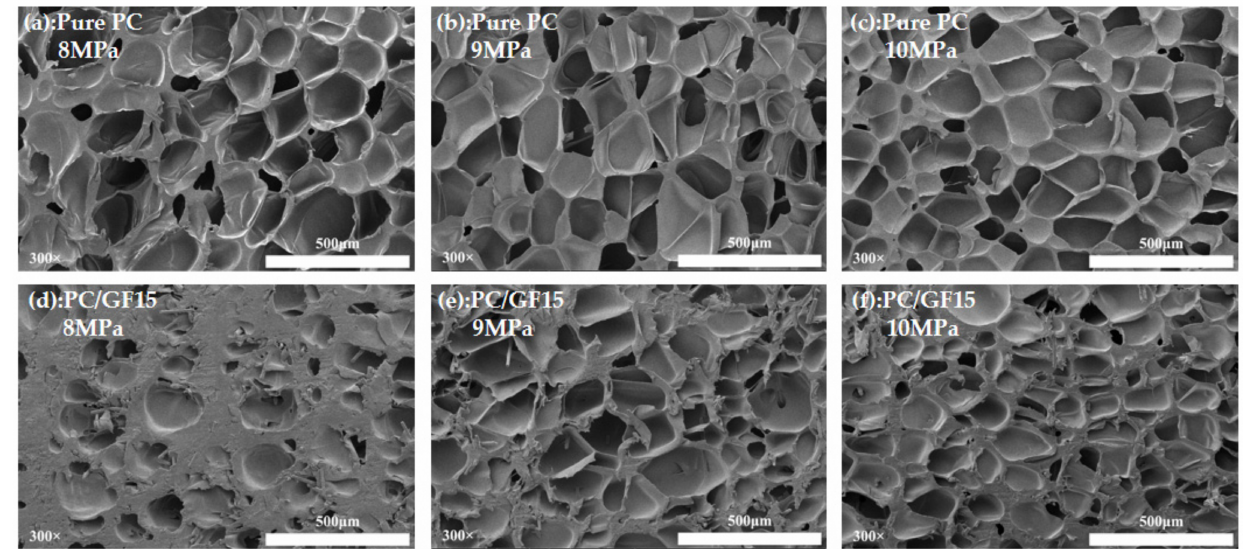
Figure 8. SEM micrographs of foamed PC and PC/15 % GF at different saturation pressure.